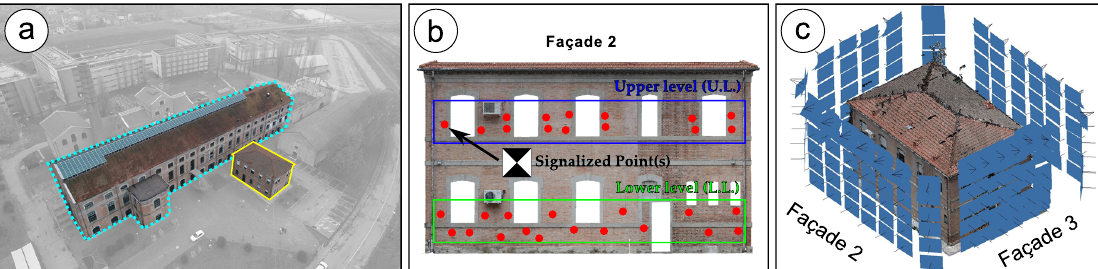
Figure 1. ( a ) Detail of the urban environment around our test-site building (in yellow). The adjacent obstacle is evident (in cyan); ( b ) example of Signalized Point (SP) position on two different levels; and, ( c ) scheme of image acquisitions with generated model. Pictures of F. 3 were captured closer to the test-site building due to the adjacent